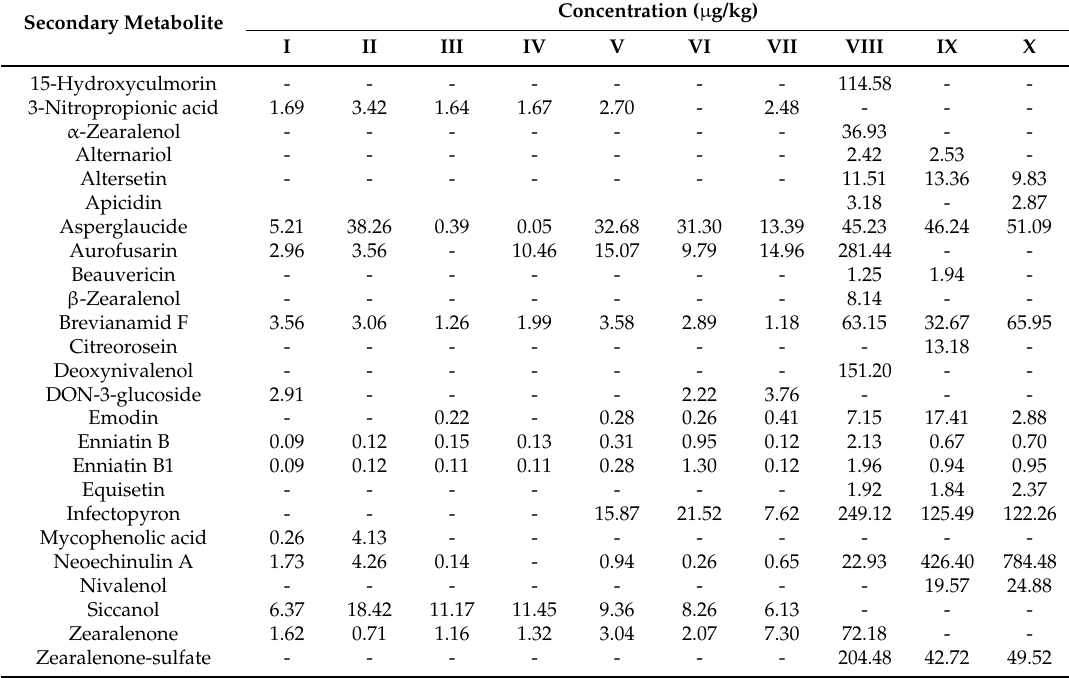
Table 8. Secondary metabolites in settled dust